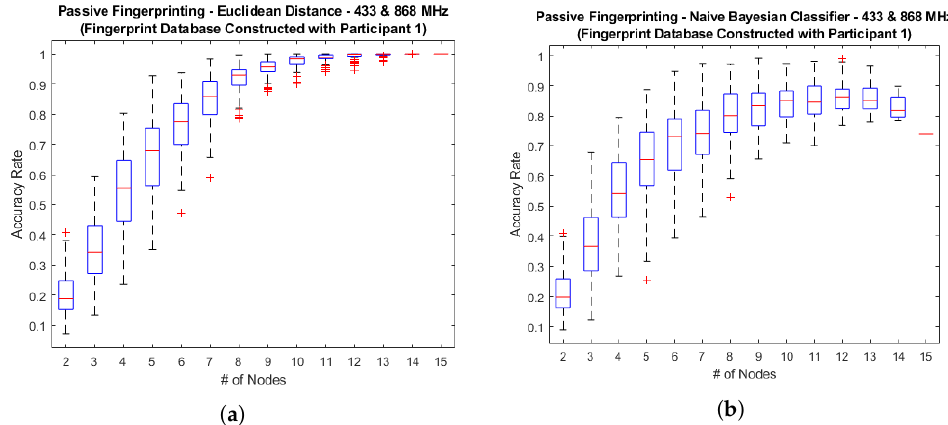
Figure 9. Accuracy rates obtained for both the ( a ) Euclidean and ( b ) Bayesian methods on a combination of 433 MHz and 868 MHz RSS data, when only data from participant 1 was used for